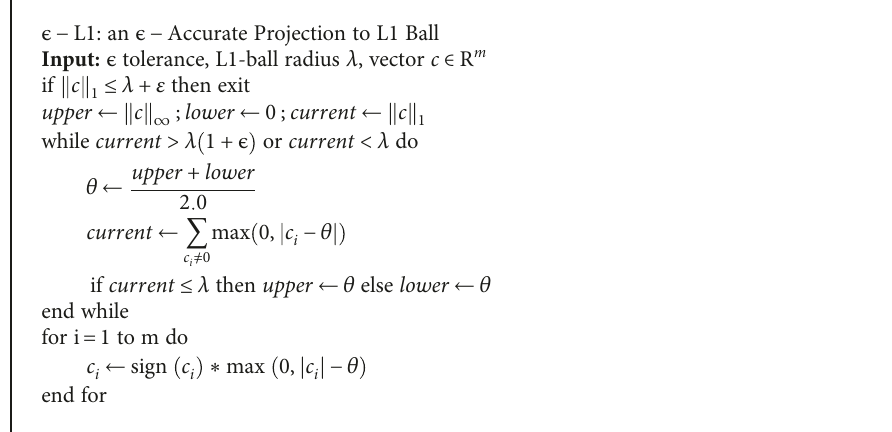
Algorithm 2: Pseudocode of Mini Batch K-means algorithm for sediment sample data